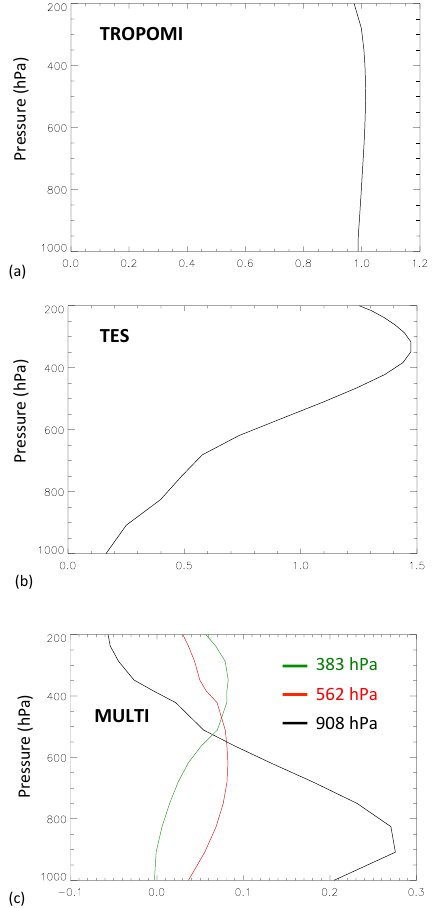
Figure 2. Averaging kernels for the different instrument configu- rations: (a) TROPOMI column averaging kernel; (b) TES column averaging kernel; (c) multi-spectral averaging kernels at three pres- sure levels: 908, 562 and